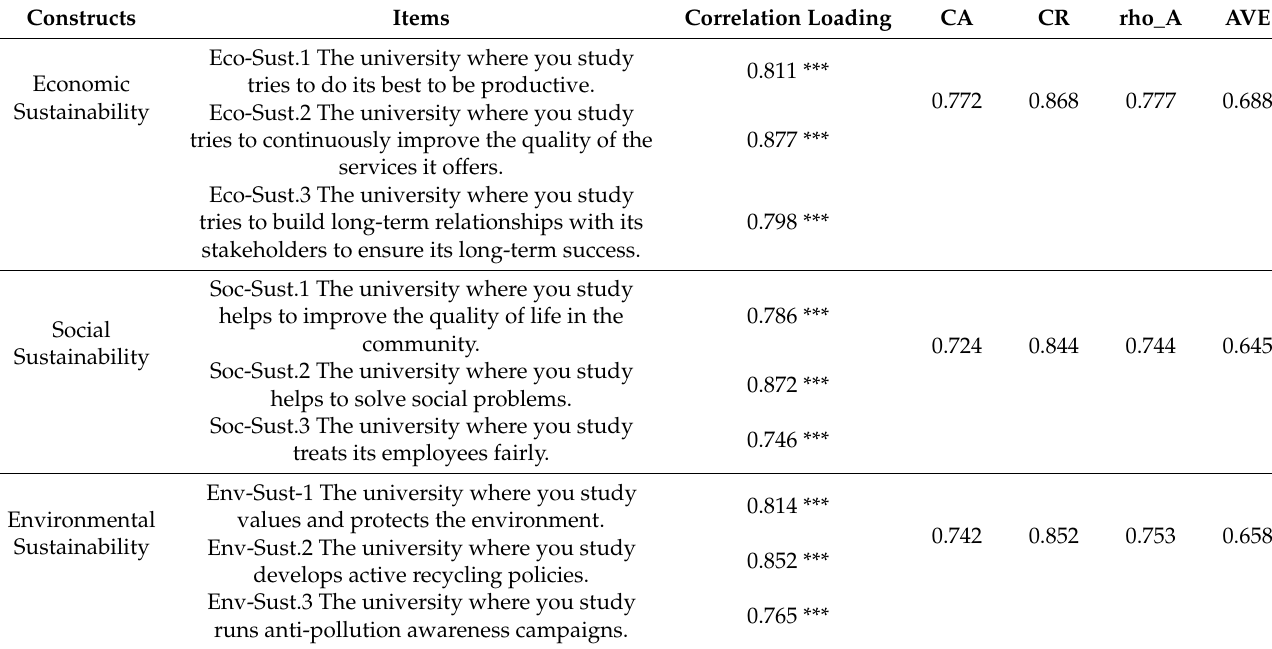
Table 3. Measurement Items.